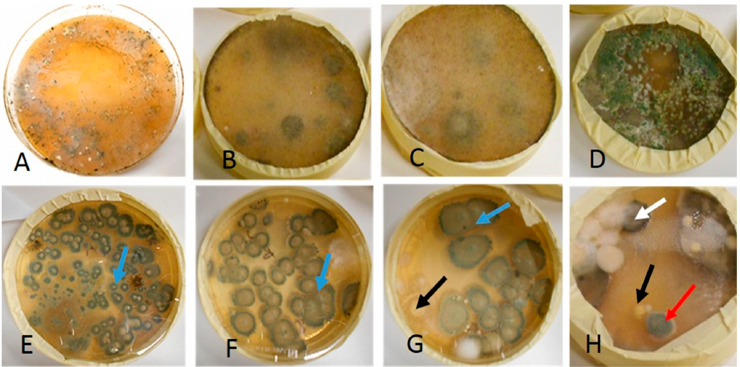
Figure 7. Fungal colonies cultivated from settled dust sampled before (upper row) and after (lower row) the ventilation improvement. Panels ( A – C , E – G ) are cultures from dust samples collected from Classroom 2. Panel ( D ) is a culture from dust collected in the lobby, while Panel ( H ) is a dust culture from Classroom 1. The dust samples were cultivated on MEA and incubated for four weeks at room temperature. The plates in Panels ( A , D ) contained over 100 green, Trichoderma -like colonies. Colonies in Panel D overgrew the other fungal colonies within two weeks of incubation indicating potential mycoparasitism. The plates in Panels ( B , C ) were overgrown with Rhizopus -like colonies. The plates in the lower row (Panels ( E – H )) contained mainly green Penicillium colonies (blue arrow). The plates in Panels ( G , H ) contained yellow Aspergillus colonies (black arrow), a black Aspergillus colony (white arrow), and a green Eurotium / Aspergillus colony (red